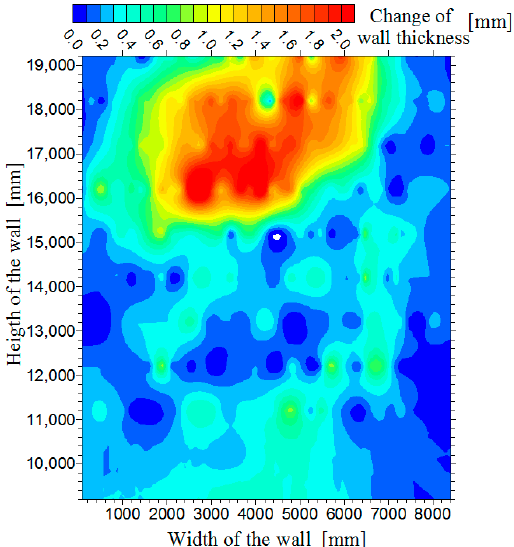
Figure 7. Changes in evaporator tube thickness, determined based on periodic measurements (in 2014 and 2017) by ultrasonic technique. Reprint with permission [38].